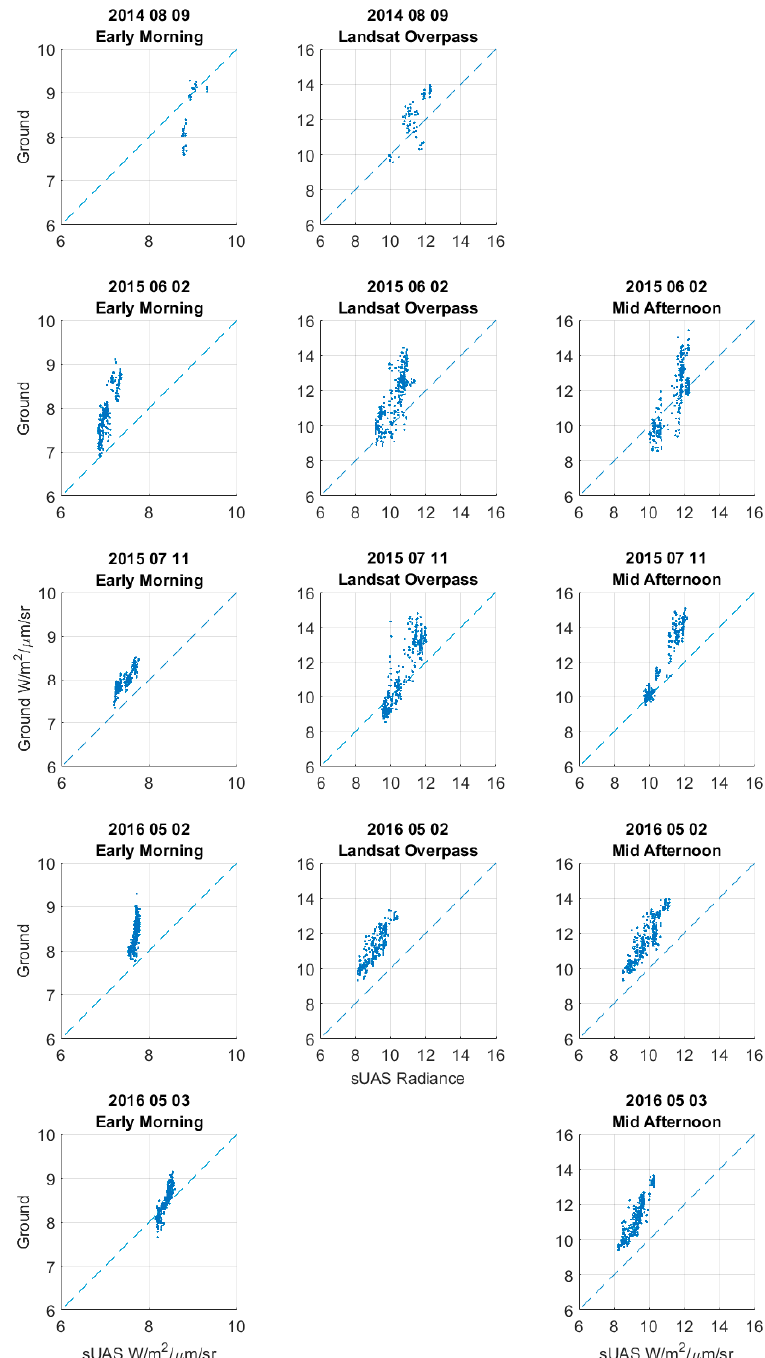
Figure 9. Radiance (W/m 2 /sr/ µ m) from sUAS (horizontal axis) and ground pixels (vertical axis) for all the sUAS flights in the site of study. The left column is for early morning, a center column for Landsat overpass and the right column for mid-afternoon times respectively.